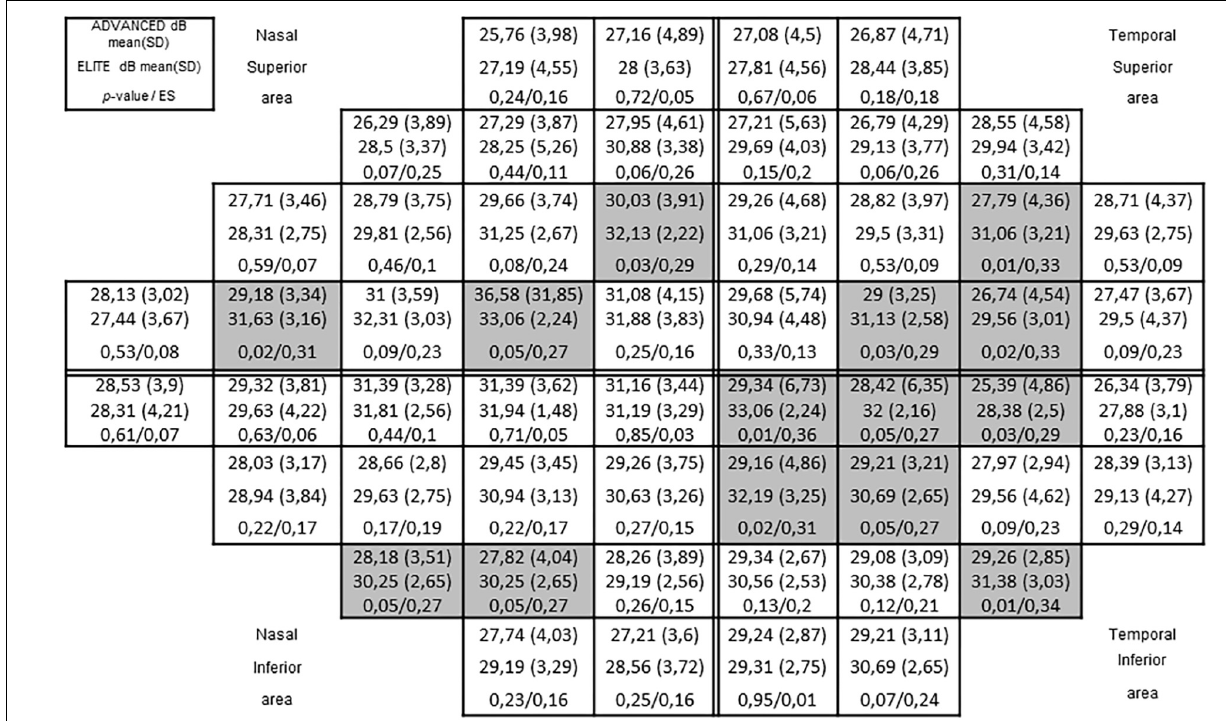
FIGURE 1 | Frequency-doubling technology perimeter (FDT) visual field results between advanced and elite groups. The complete sector shaded cells represent significant differences ( p < 0.05). P- values of 0.00 represents P- values < 0.005.